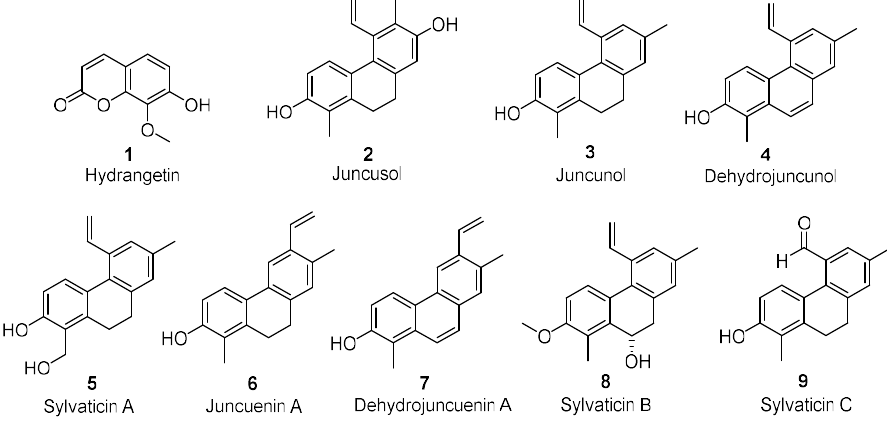
Figure 2. Isolated compounds from CH 2 Cl 2 and n -hexane fractions.